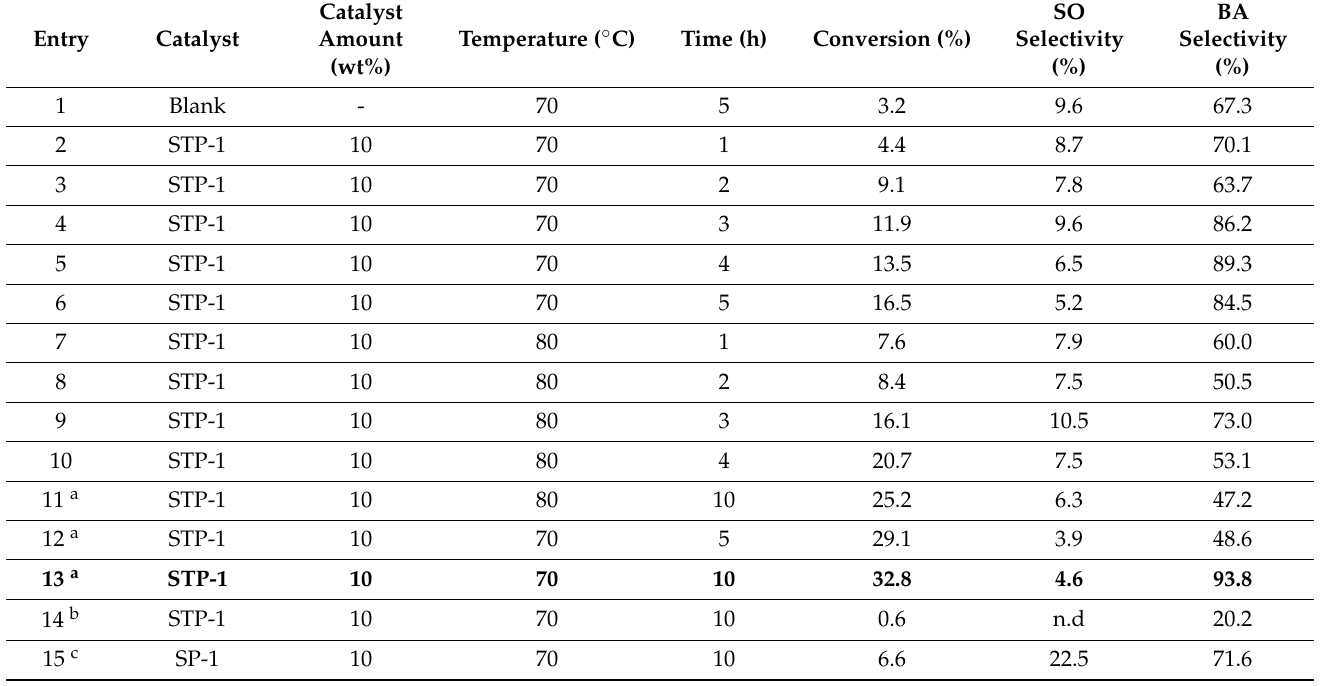
Table 1. Optimization table for the liquid phase oxidation of styrene over STP-1.